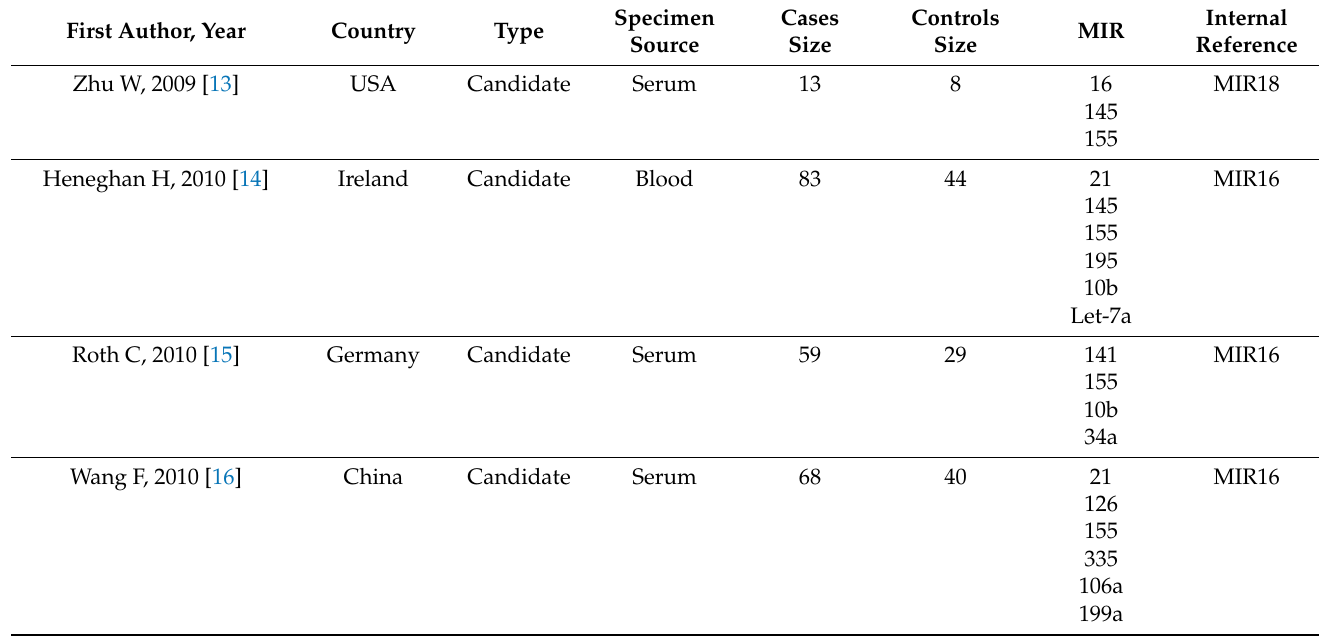
Table 1. General characteristics of the studies included in systematic review on the role of microRNA in breast cancer